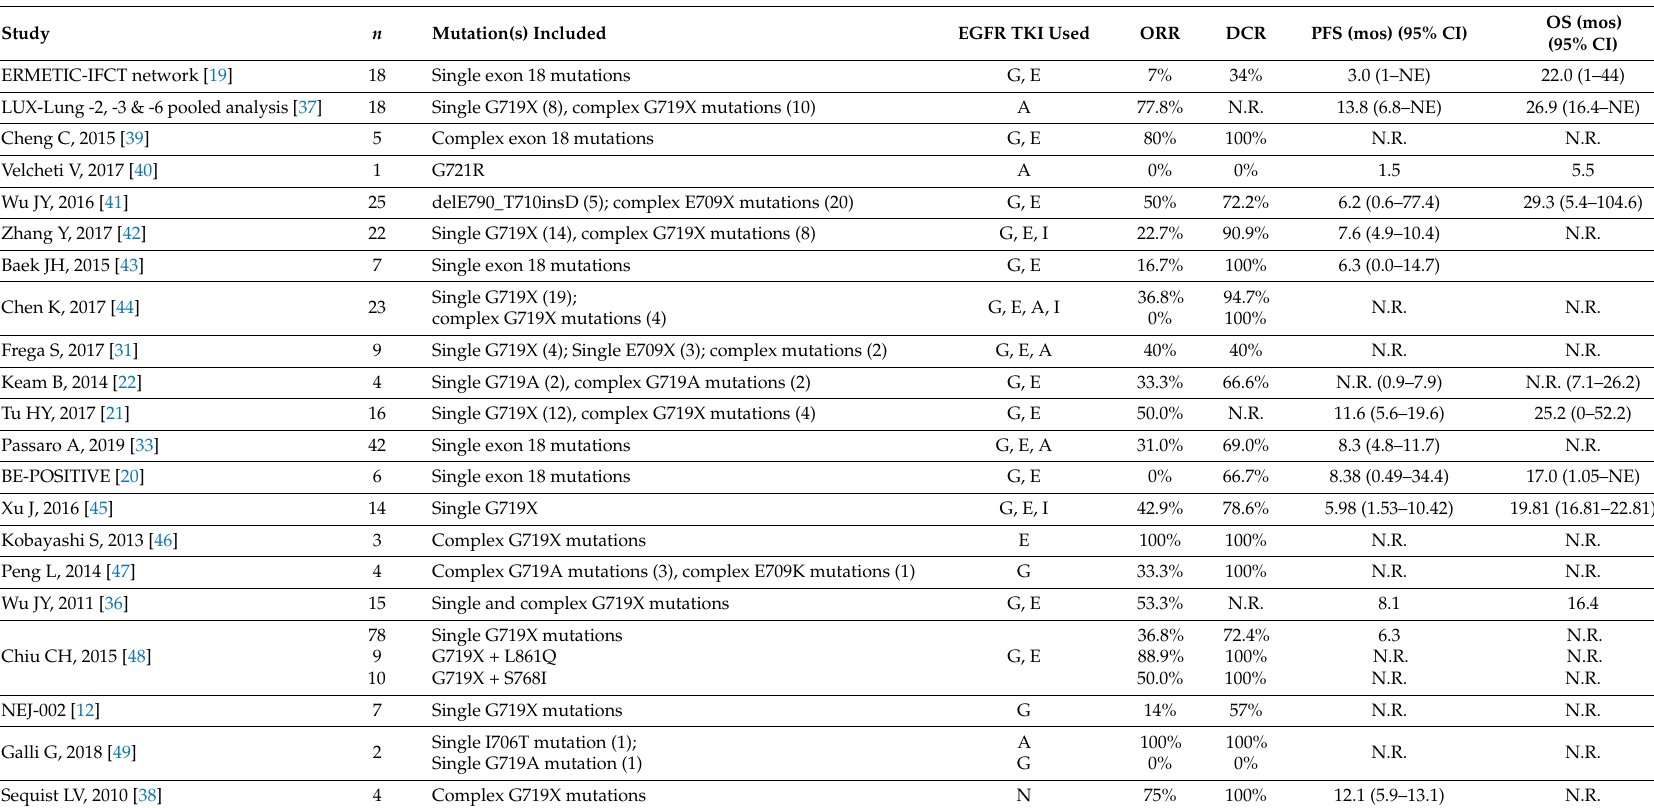
Table 2. Activity of first-/second-generation EGFR TKIs in patients harboring exon 18 mutations, either alone or as complex